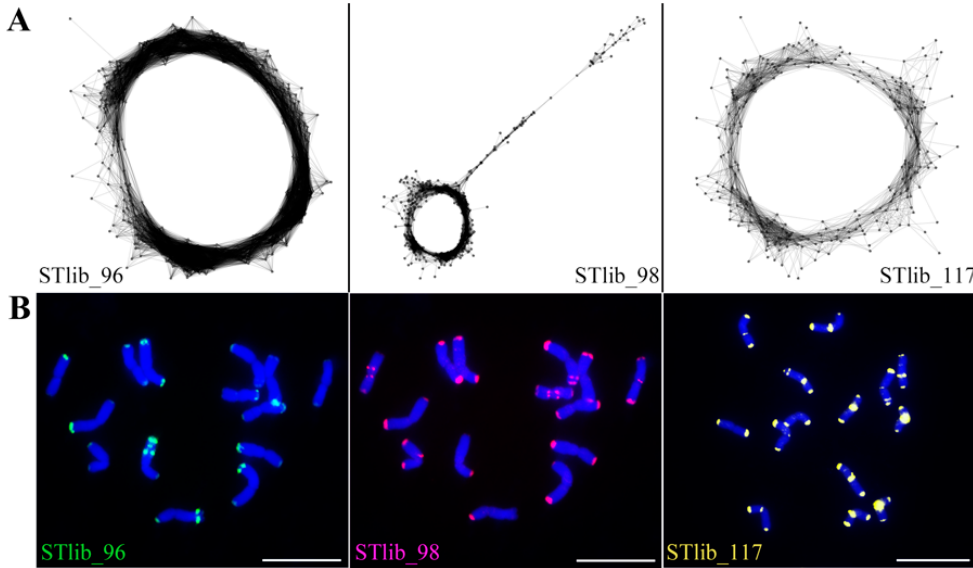
Figure 3. Identification and characterization of P. libanotica enriched sequences. ( A ) Graph representation of repeat clusters read similarities of P. libanotica in silico. Nodes are placed according to sequence similarity, where similar sequences are close together and connected with edges (gray lines). The circular or globular structure of graphs is typical for repeats with the tandem arrangement in the genome. ( B ) Chromosome distribution of tandem repeats (STlib_96 in green, STlib_98 in magenta, and STlib_117 in yellow) in P. libanotica , respectively.